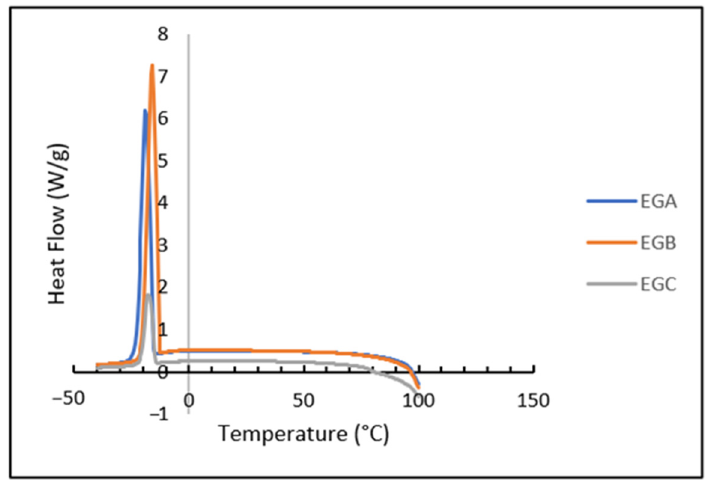
Figure 4. Differential scanning calorimetry (DSC) cooling curve of EGA, EGB and EGC.